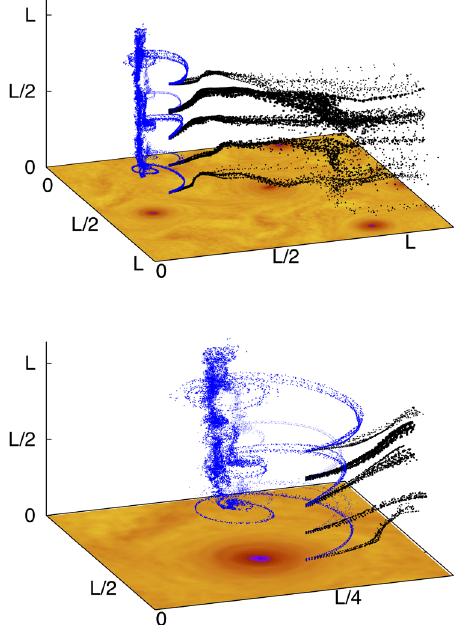
FIG. 2. 3D rendering of the evolution of two different puffs of particles, one light (blue) and one heavy (black), released in a turbulent flow at Rossby number Ro ¼ 0 . 25 . Particles are injected on the same rotation axis and with a velocity equal to that of the underlying fluid. The dispersion dynamics follows two different evolutions: light particles get trapped by the nearest columnar vortex and diffuse mainly vertically, while heavy particles tend to avoid the columnar structures and diffuse mainly horizontally. In the bottom plane, we show the intensity of the vertical vorticity averaged along the rotation axis. Bottom panel shows an enlargement of the top panel close to one intense vertical